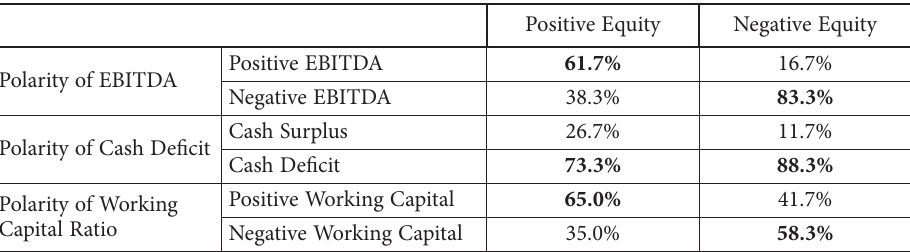
Positive Equity Negative Equity